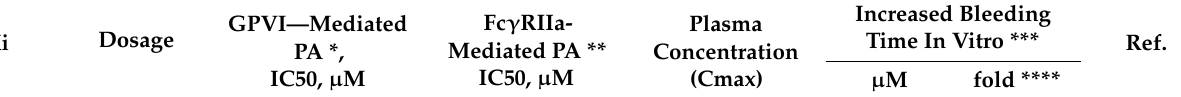
Table 2. Btk-inhibitors (BTKi): Comparison of IC50 values for inhibition of Btk-dependent platelet aggregation (PA) by GPVI or Fc γ RIIa stimulation of blood, therapeutic plasma concentrations and blood concentrations which increase bleeding time in